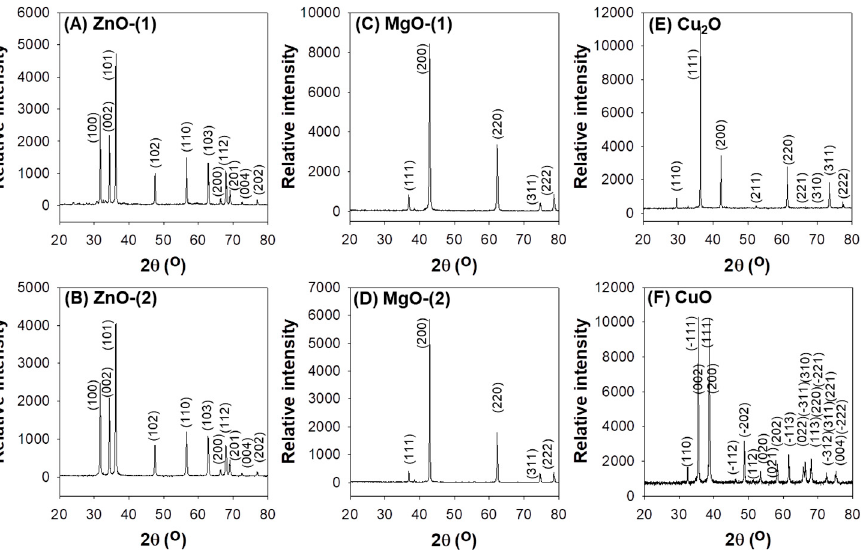
Figure 2. PXRD patterns of metal oxide (MO) particles: ( A ) ZnO-(1), ( B ) ZnO-(2), ( C ) MgO-(1), ( D ) MgO-(2), ( E ) Cu 2 O, and ( F ) CuO.